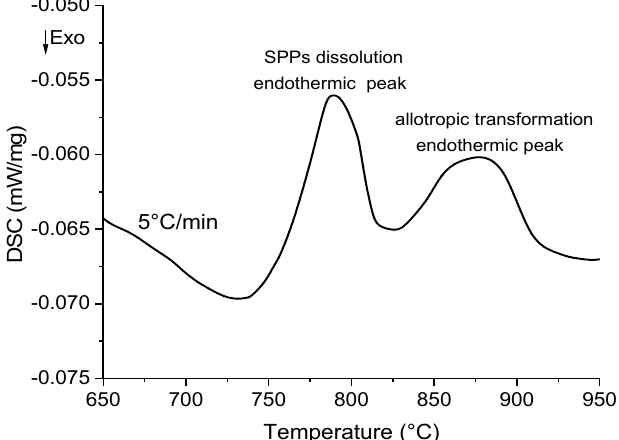
Figure 3. A peak separation result of two endothermic enthalpy peaks of N36 zirconium alloy DSC curve acquired at 5 °C/min. Table 2. α to α + β transition temperature and Peaking values of N36 zirconium alloy obtained by DSC measurement.